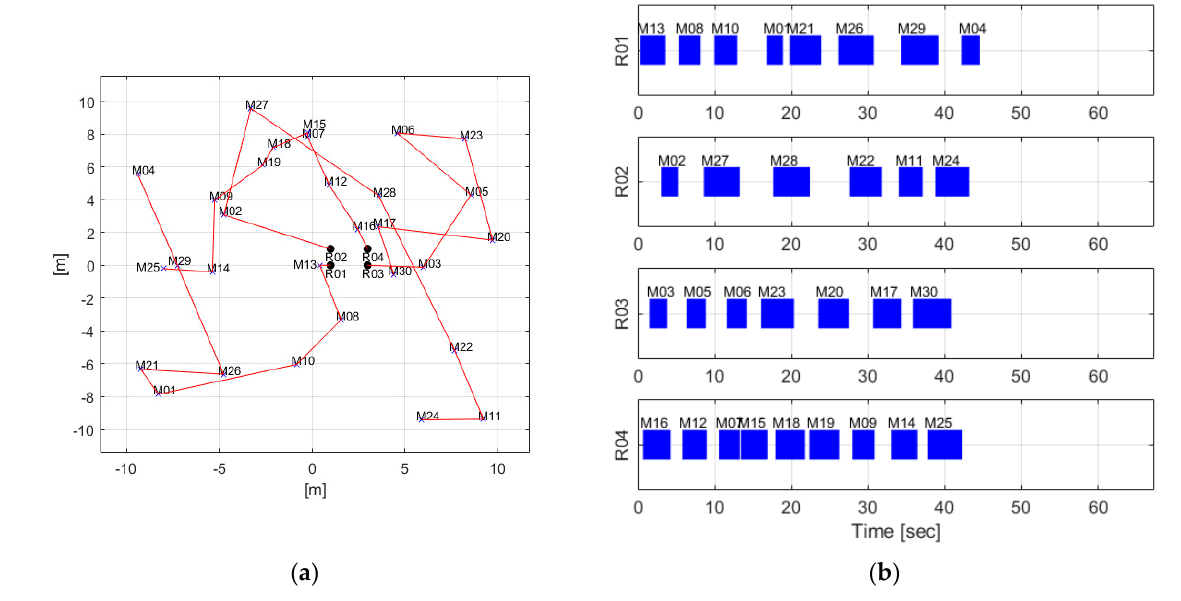
Figure 6. The results for medium case using proposed algorithm: ( a ) 2D situation map; ( b ) timetable. The calculation times of CBBA, TACTAR, and the proposed algorithm for the simple case are 0.1815 s, 0.0754 s, and 0.1636 s, respectively. Like the results for medium, the proposed algorithm has a lower computational cost than CBBA for the huge case. The computational cost is highly increased compared to the simple case, but it is still fast to run it in real-time.